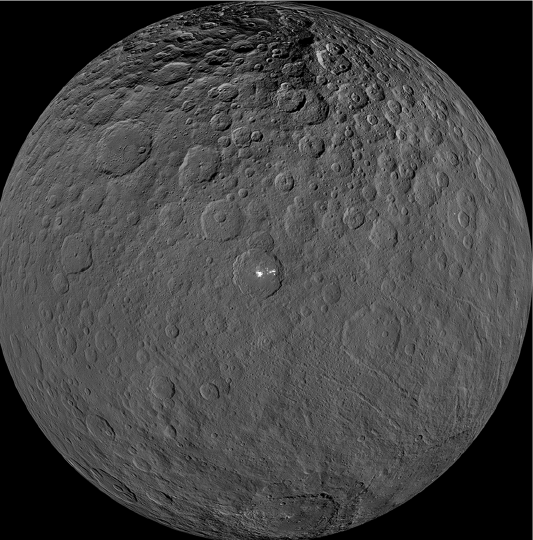
Figure 1. Image of Ceres’ surface made by Dawn’s framing cameras in clear filter. The brightest region on Ceres, called Cerealia Facula, is highlighted in Occator Crater in the center of this image. Vinalia Faculae, the set of secondary bright spots in the same crater, are located to the right of Cerealia Facula (Image credit: NASA/JPL ‐ Caltech/UCLA/MPS/DLR/IDA).